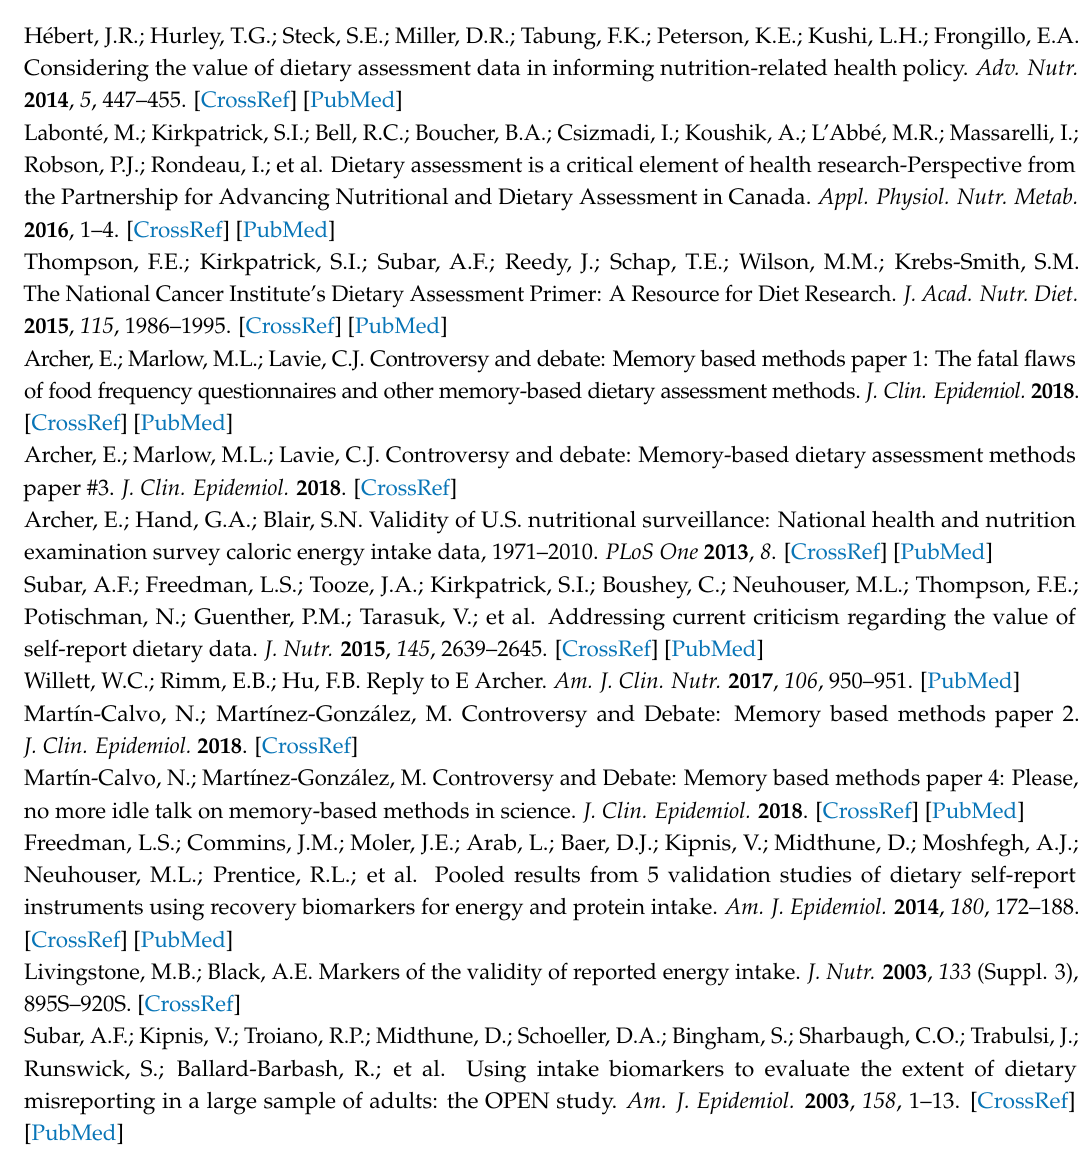
s1. Table S1: Anthropometric characteristics before and after controlled feeding phases of 4 to 6 weeks in men and